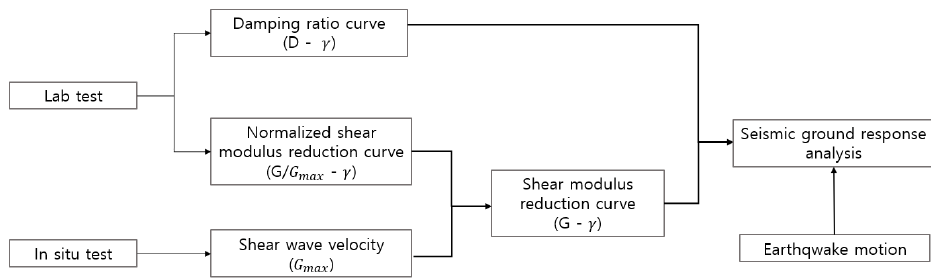
Figure 4. Flow of seismic ground response analysis.